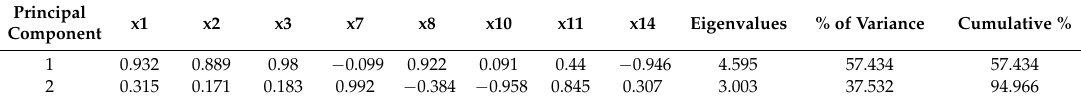
Table 9. PCA of selected variables of LCTIP by SPSS 22.0.